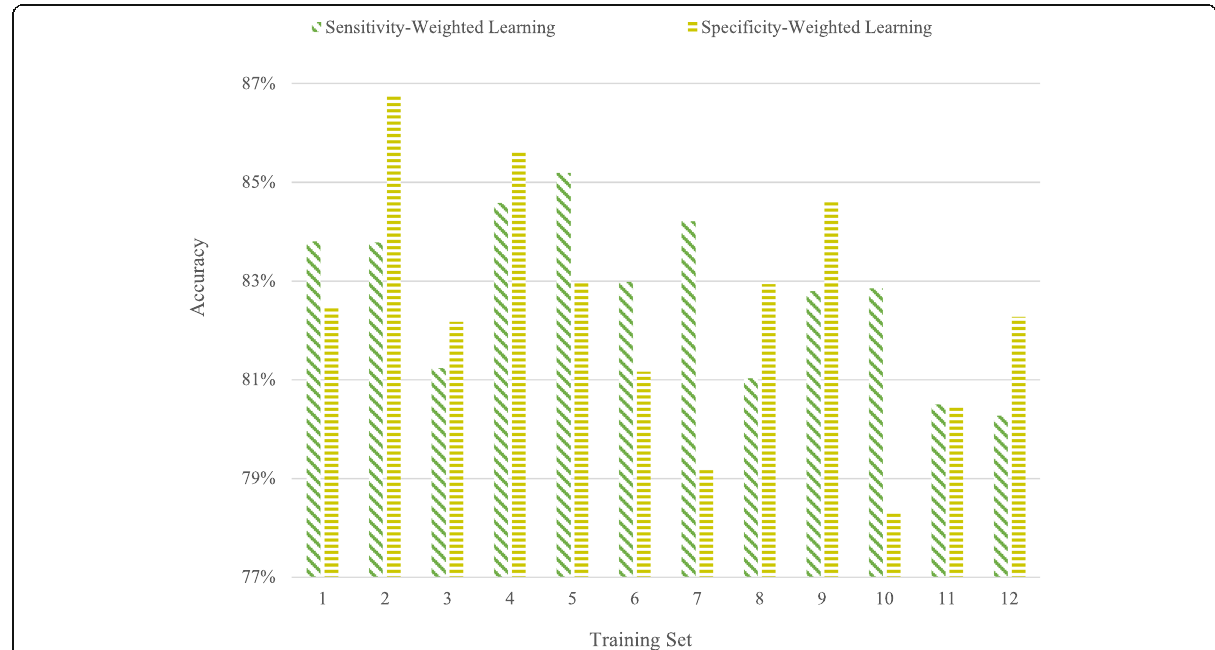
Fig. 5 The accuracy in the training process with the adaptive sensitivity-weighted and adaptive specificity-weighted improvement for the